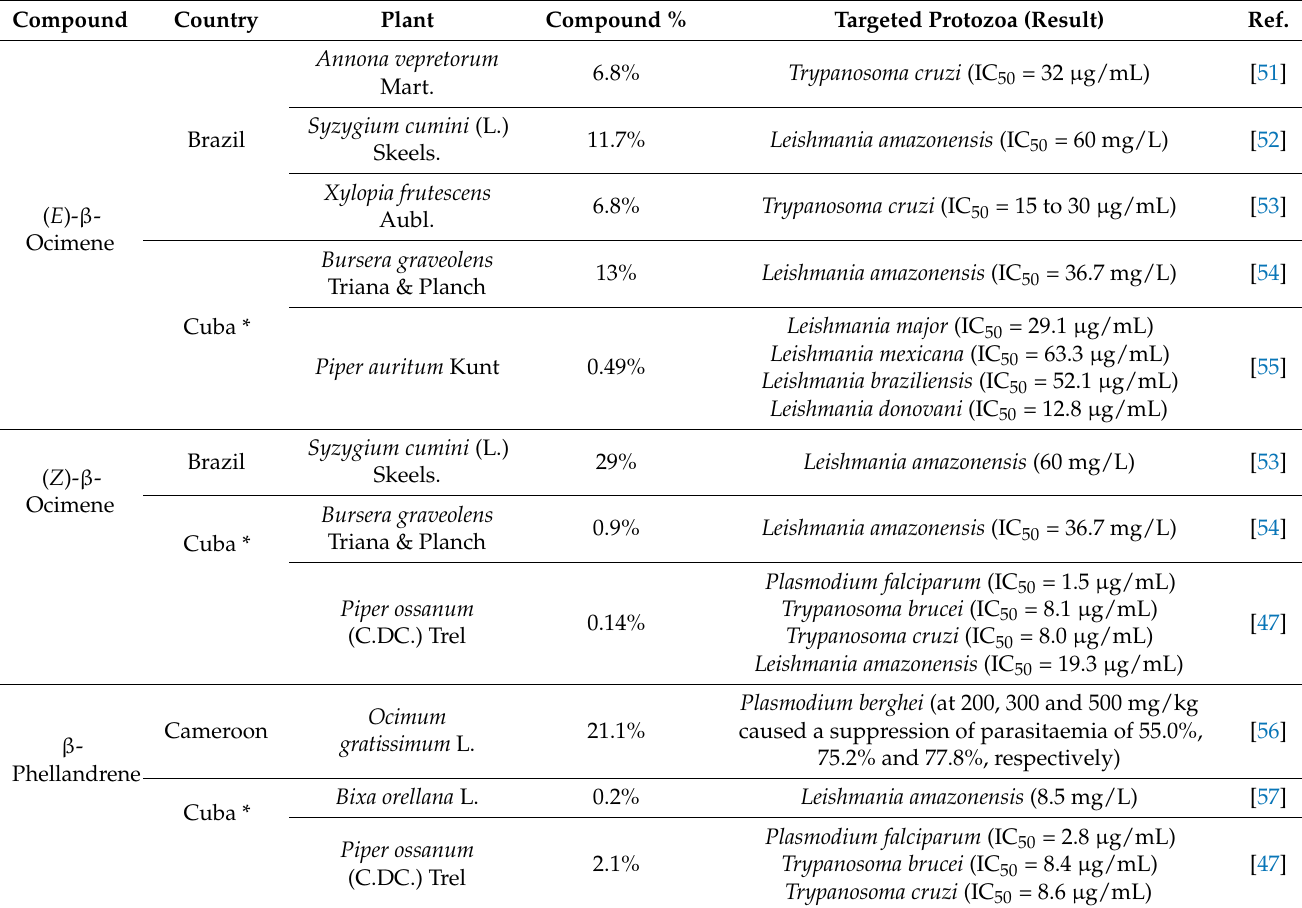
Table 4. In vitro antiprotozoal profile of Cuban and according literature review of EOs that present identified compounds in this study (previous shown in Figure